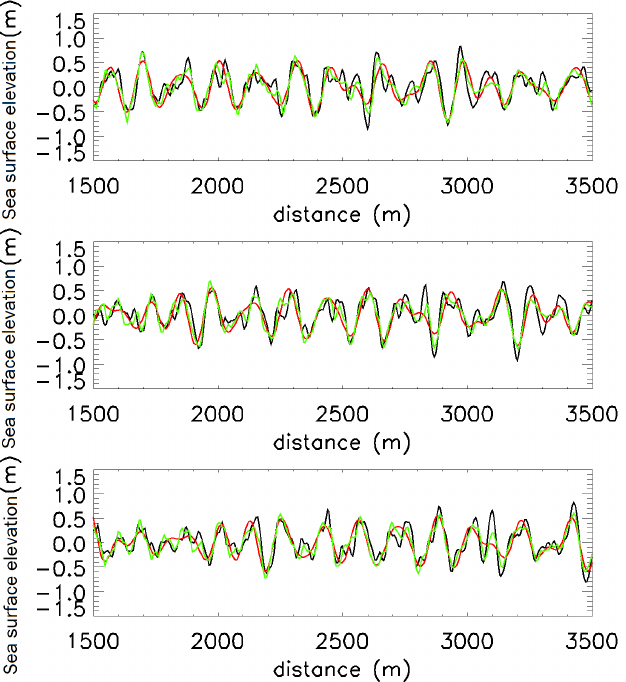
Figure 14. Reconstructed function ),( tx instant [0, 36, 76] s, compared to the simulated sea surface elevation ),( tx  (black